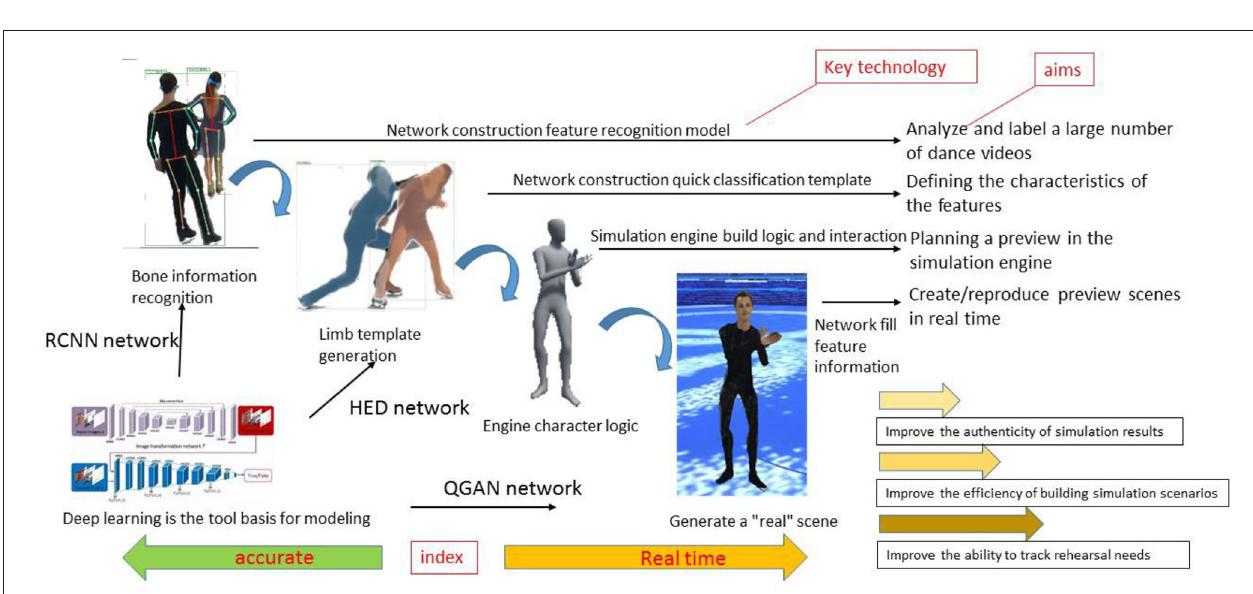
FIGURE 1 | Comparison between the general process of creative generation and the programmatic form.